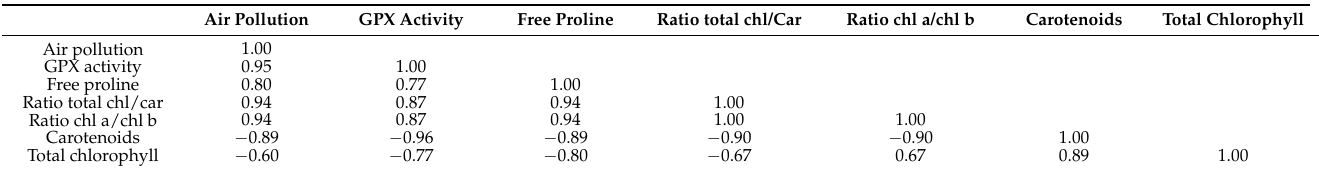
Table 6. Pearson correlations between the level of air pollution and levels of studied biochemical markers in leaves of P. nigra from four experimental plots (n = 72, 3 individuals × 4 plots × 6